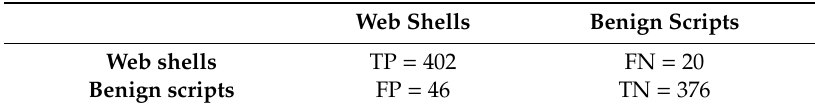
Table 3. The average values (with feature selection) of TP, FP, TN, and FN under 100 independently repeated experiments.